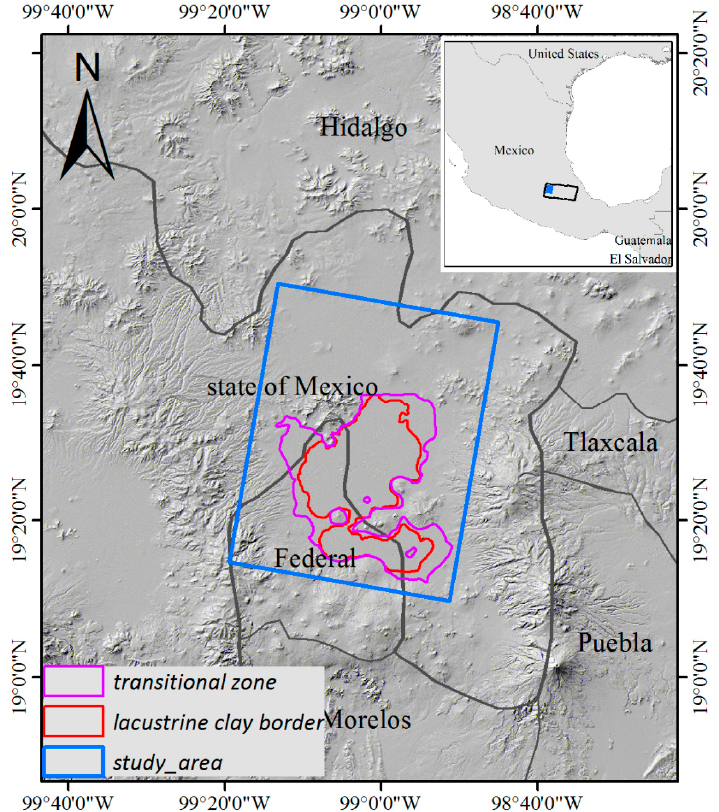
Figure 2. The coverage of Mexico City soil composition (plot according to [31]) and study area. The black box in the upper right figure indicates the scope of the Sentinel-1 dataset and the blue rectangle is the study area. In the main figure, the purple and red lines represent the scope of the transitional zone and the lacustrine clay border and the blue box denotes the study area. The lacustrine clay border defines the scope of clayed layer overlaying sand and gravel aquifer, transitional zone distinguishes the different geotechnical units.